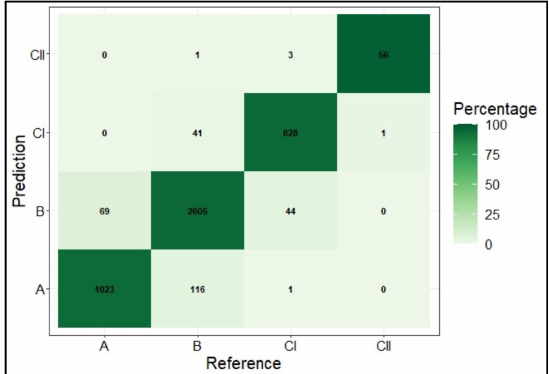
Figure 10. Confusion matrix of the classification performance of the RF